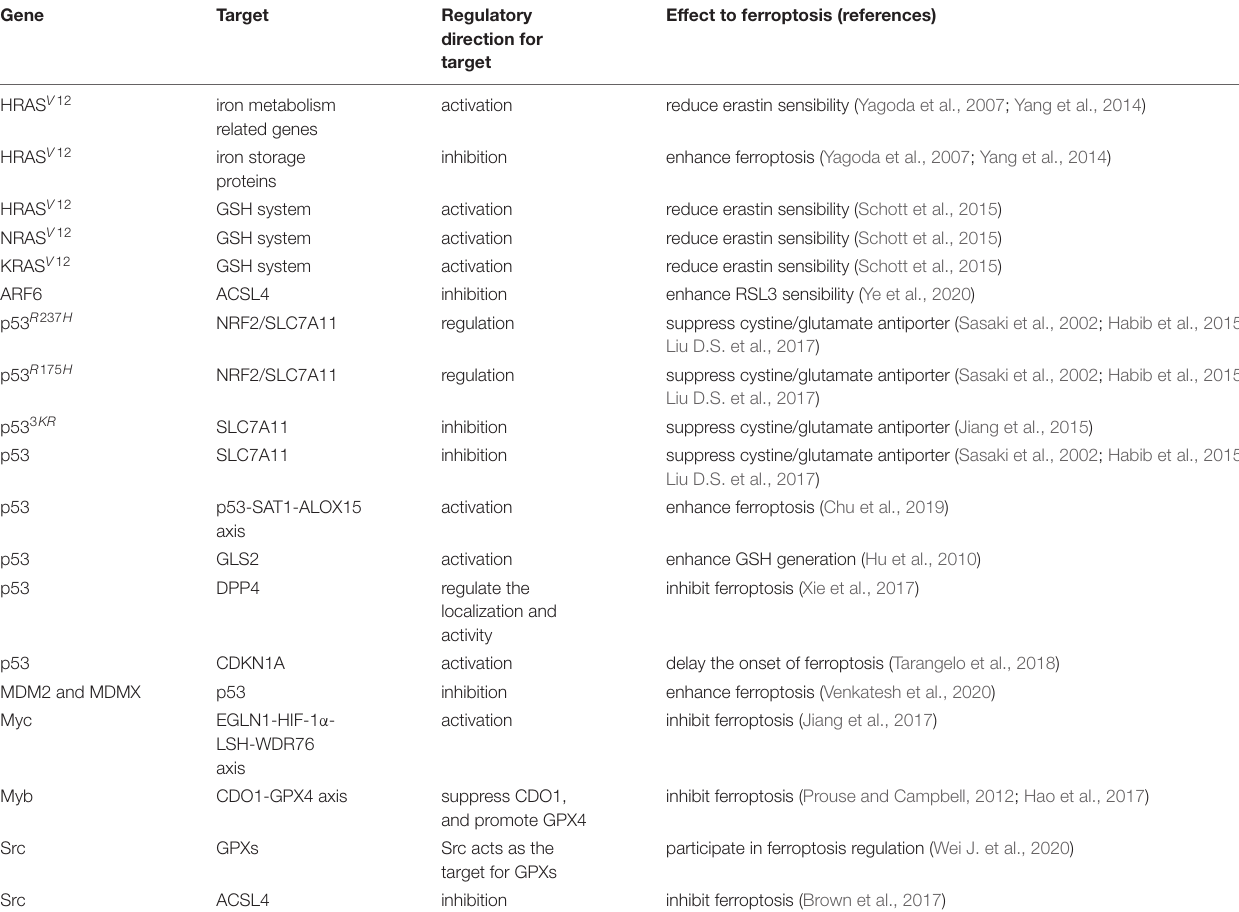
TABLE 1 | Summary of ferroptosis associated oncogenes and tumor